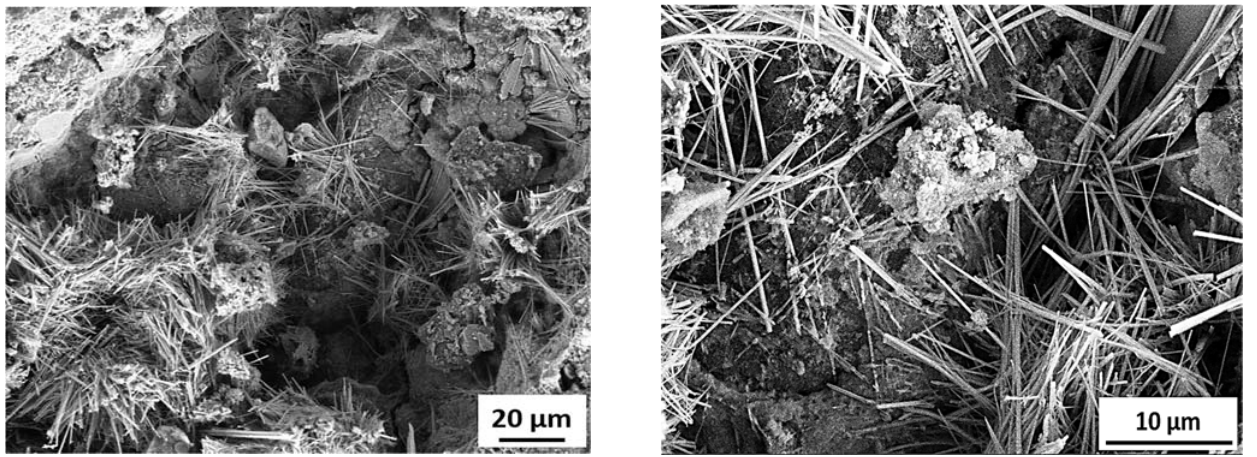
Figure 19. SEM image of specimen with 25% of RW exposed to ASR conditions.